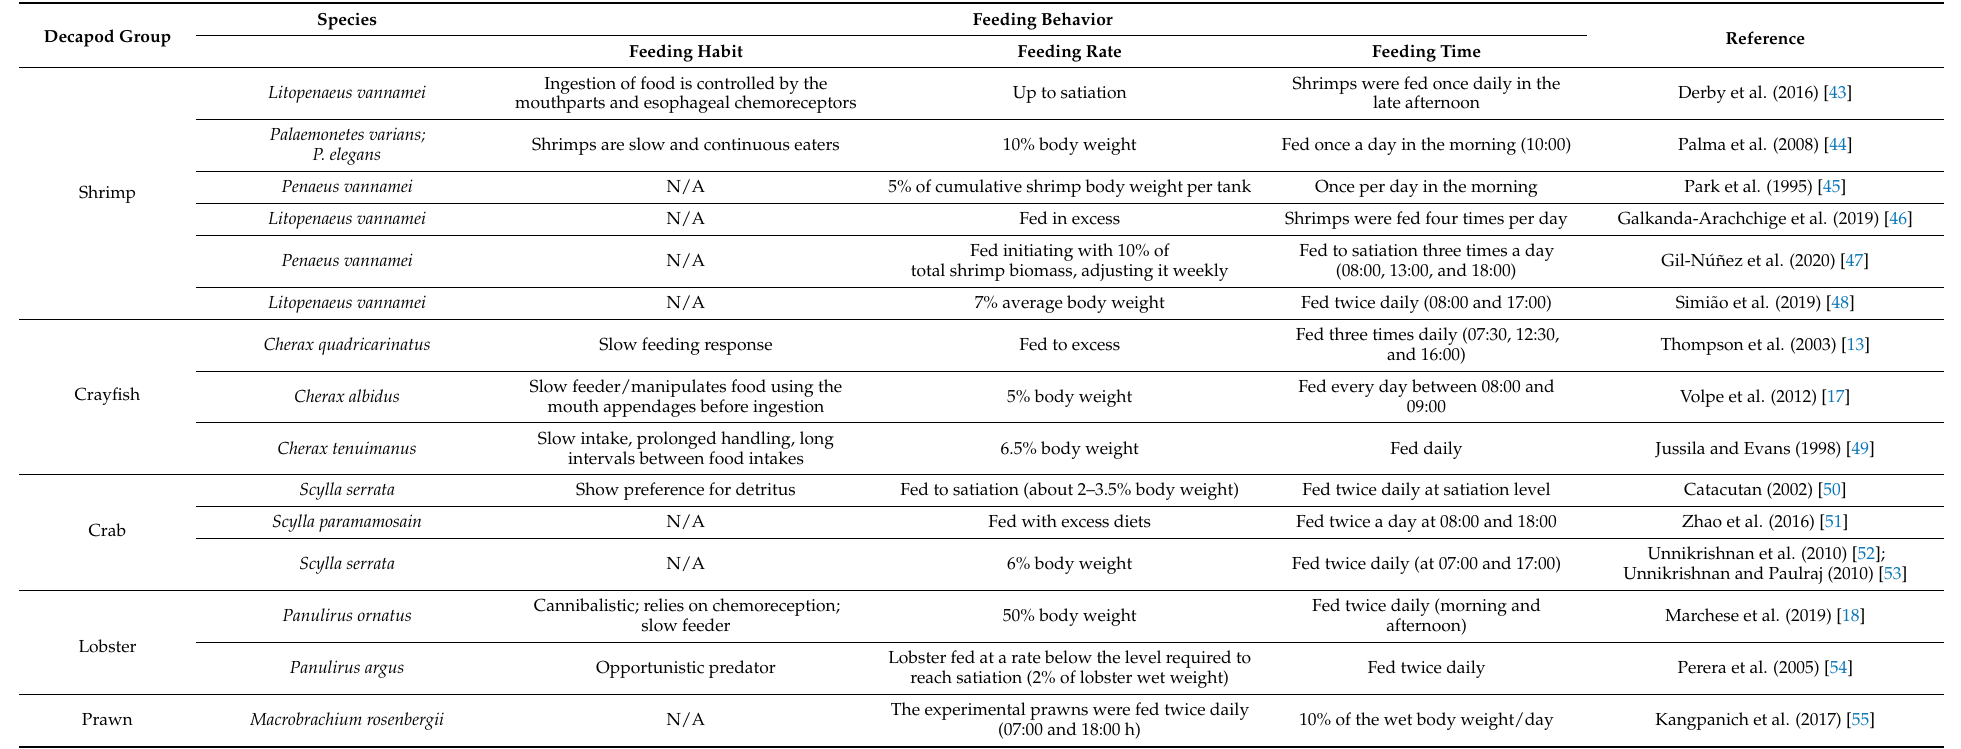
Table 1. Decapod’s feeding behaviour during the juvenile